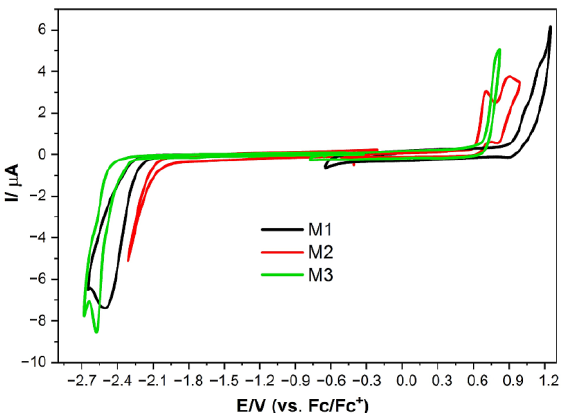
Figure 5. Voltammograms of the investigated compounds; sweep rate ν = 100 mV/s, 0.1 M Bu 4 NPF 6 in CH 2 Cl 2 .